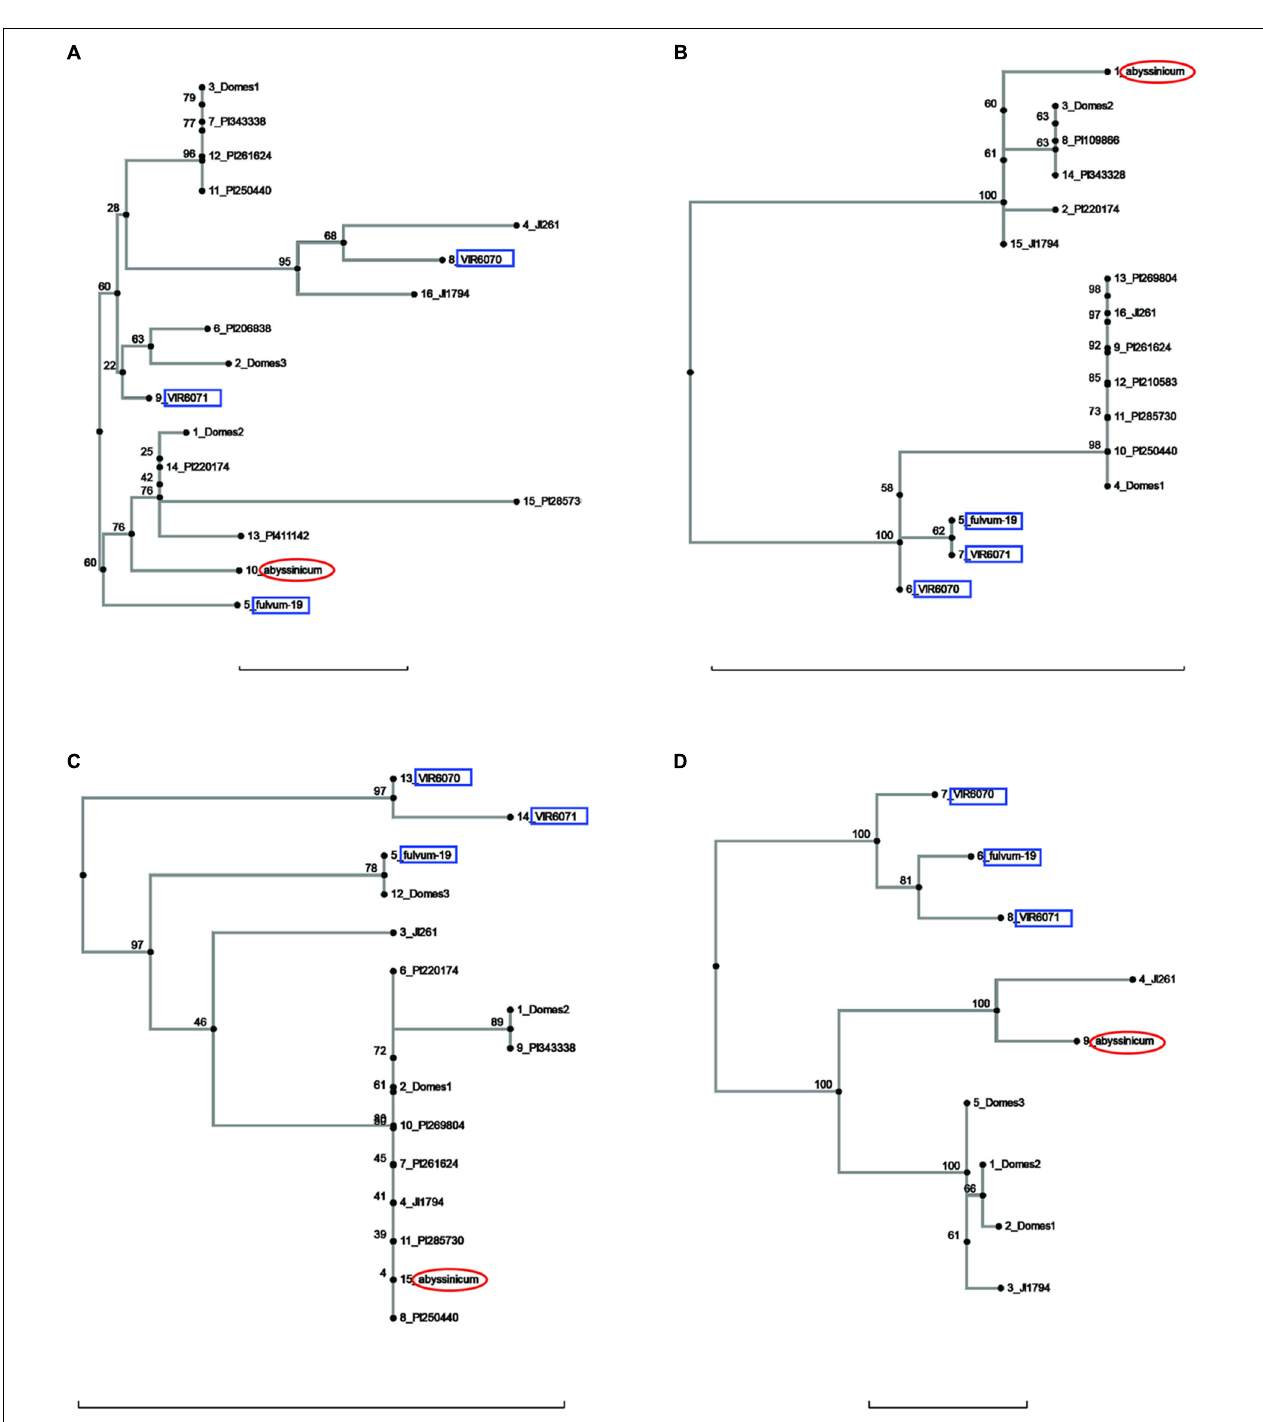
FIGURE 3 | Phylogeny trees of the alleles for (A) Peam5 , (B) Ntfy , (C) Alat , and (D) Sbm1 . The position of the allele from P. sativum ssp. abyssinicum is circled in red, those for P. fulvum accessions are boxed in blue. The position of each PI accession is presented individually, but those for the modern varieties are lumped into groups labeled Domes1, Domes2, etc. Bar at base of each cladogram represents a nucleotide substitution rate of 0.01.